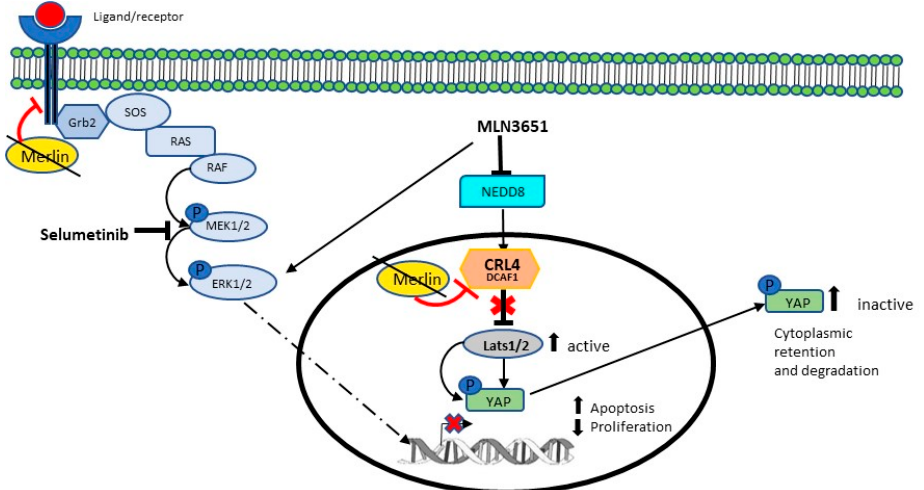
Figure 6. Inhibition of CRL4-DCAF1 and Raf / MEK / ERK signalling in Merlin-deficient meningioma. When Merlin is lost, there is an increased accumulation of growth factor receptors at the cell membrane leading to activation of downstream signalling [33]. Activation of RAF / MEK / ERK leads to increased gene transcription of the genes involved in proliferation and downregulation of pro-apoptotic proteins. CRL4-DCAF1 is hyper-activated when Merlin is lost and inhibits LATS1 / 2, in the nucleus, therefore releasing the LATS1 / 2-dependent inhibition of the YAP function, allowing YAP to regulate gene transcription [13]. MLN3651 inhibits neddylation and inhibits the activity of the CRL family of E3 ubiquitin ligases, including CRL4-DCAF1, as well as activating Raf / MEK / ERK. The MEK1 / 2 inhibitor selumetinib inhibits Raf / MEK / ERK activation when combined with MLN3651, and has an additive effect on the inhibition of proliferation and activation of apoptosis in Merlin-deficient meningioma.